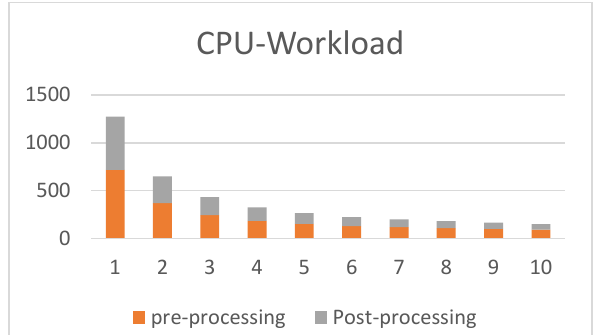
Figure 12. Comparison of time taken for multiple GPUs to process a 1600-million-pixel image in a single HPC node.